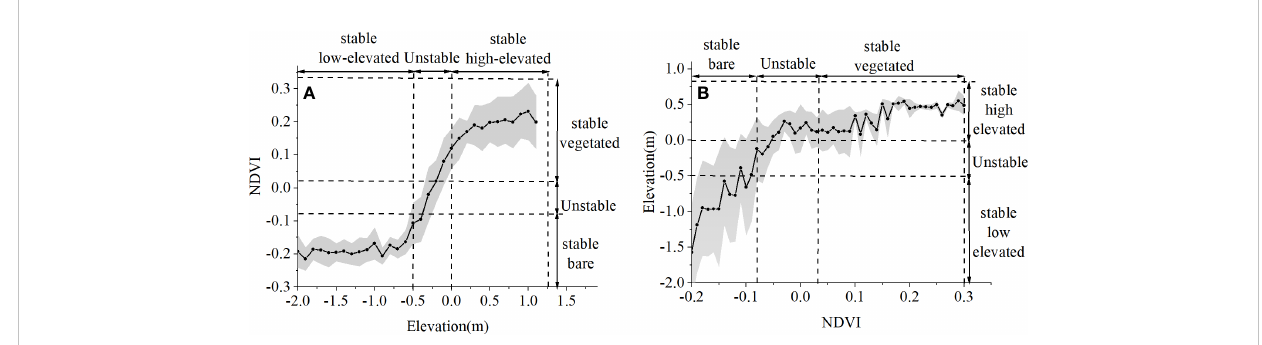
FIGURE 6 (A) NDVI variation with elevation in 2011. (B) Elevation variation with NDVI in 2011. (A) Black dots denote the mean NDVI value of elevation classes with 0.1 m intervals; the gray area refers to the standard deviation of NDVI for each elevation class. Elevation ranges are indicated (with vertical black-dashed lines) and denoted as “ stable low-elevated ” , “ unstable ” , and “ stable high-elevated ” based on the distribution of elevation in Figure 5C. (B) Black dots denote the mean elevation of NDVI classes with 0.01 intervals; the gray area refers to the standard deviation of elevation for each NDVI class. NDVI ranges are indicated (with vertical black-dashed lines) and denoted as “ stable bare ” , “ unstable ” and “ stable vegetated ” based on the distribution of NDVI in Figure